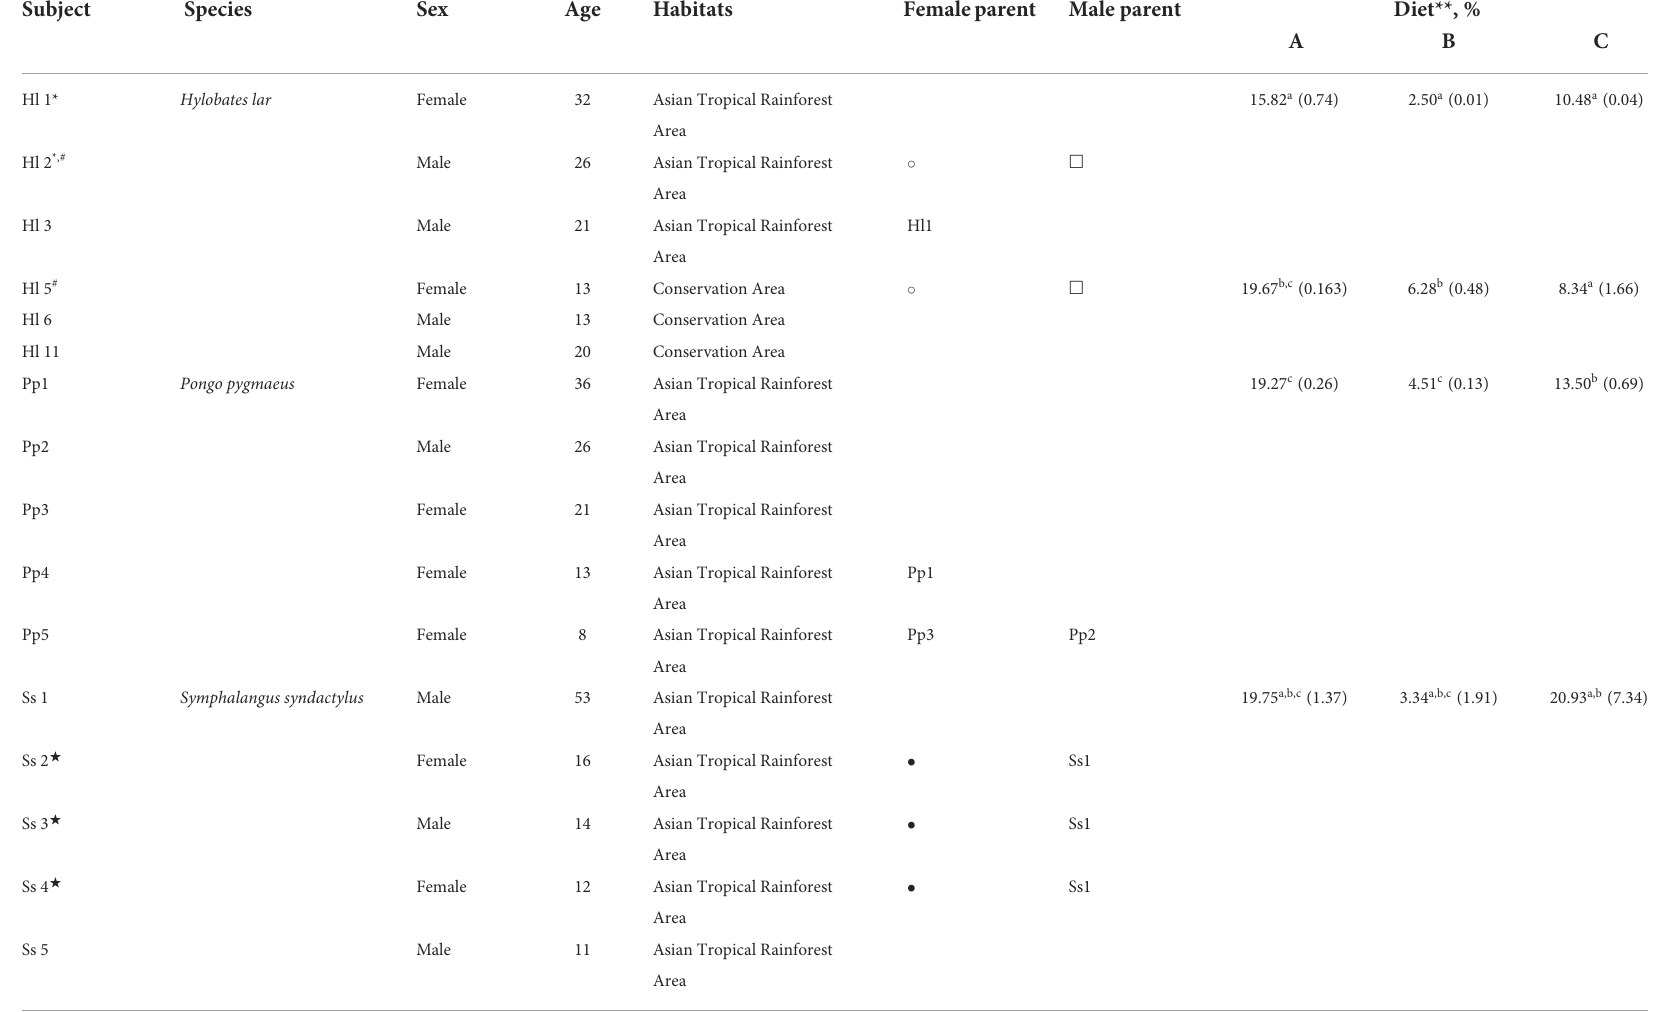
TABLE 1 Animal subjects in the